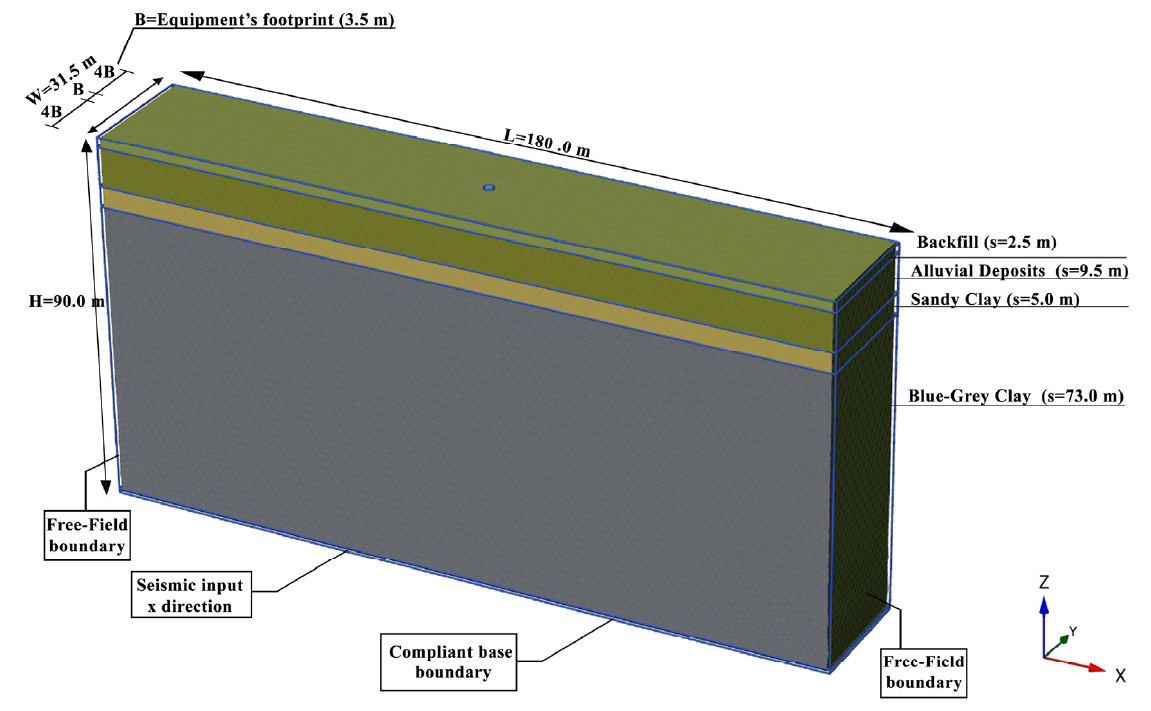
Figure 18. Model geometry and boundary conditions.